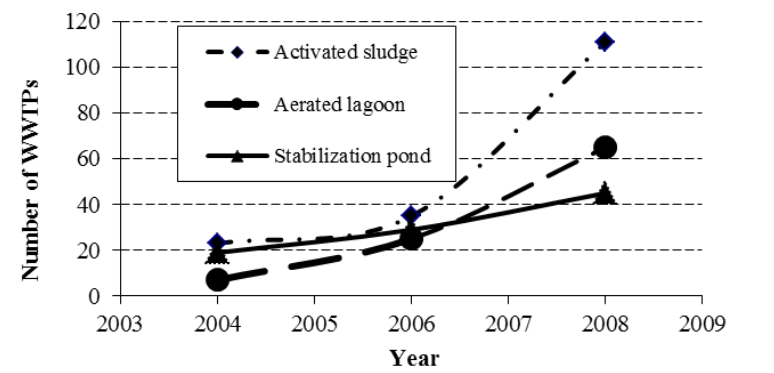
Fig. 1. Tendencies for different systems in terms of number.